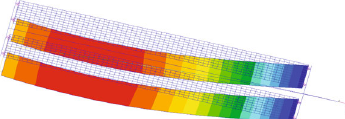
Figure 2: The fi nite element mesh of the fl exible solar array and its fi rst-order bending